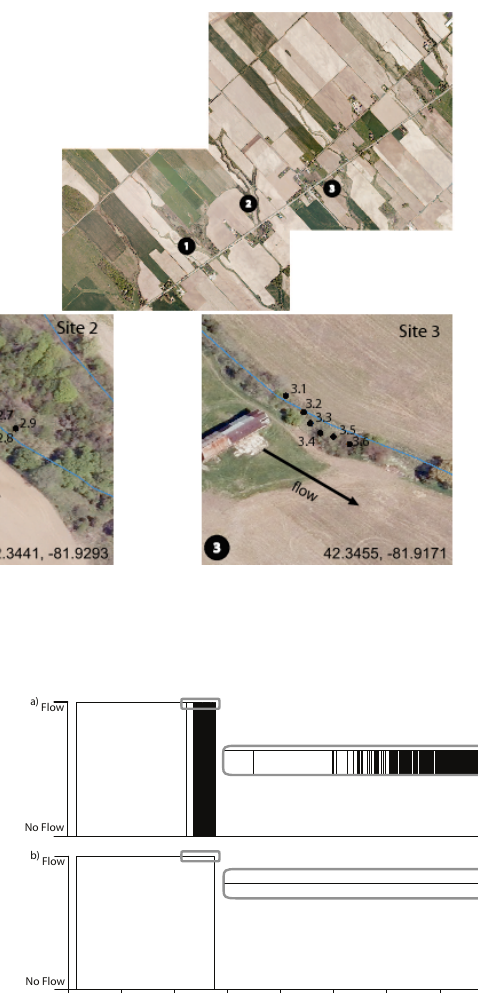
Fig.5. Rawdata (a) andpost-processeddata (b) withthenoiseremovedforonesensorhead. Fig. 5. Raw data (a) and post-processed data (b) with the noise removed for one sensor